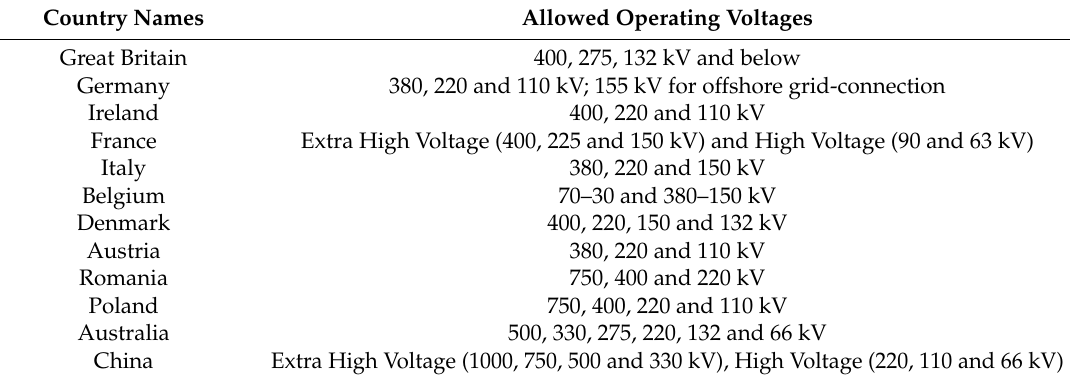
Table 2. Rated operating voltage levels in different countries